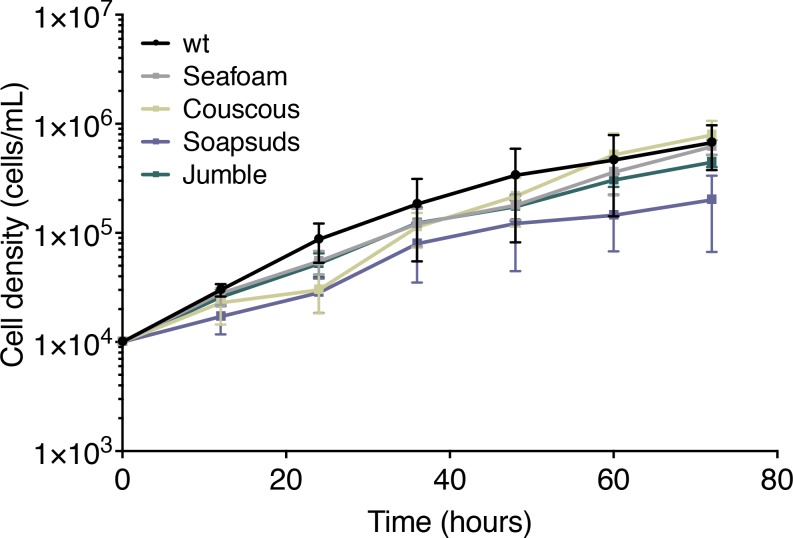
Class C mutant growth curves.Mutant and wild type cells were plated at a density of 1 × 104 cells/ml and counted every 12 hr to assess growth. Mean density plotted ±SD (n = 2 biological replicates with three technical replicates).